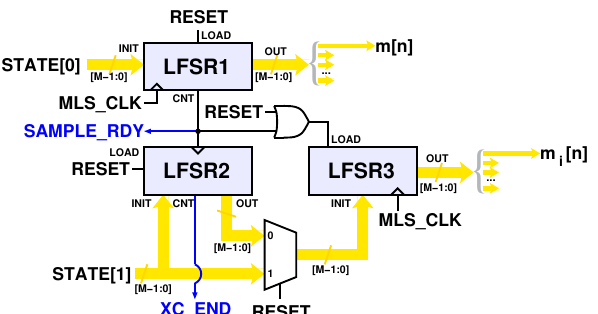
Figure 7. Circuit schematic of the digital control unit (DCU) for the generation of MLS sequences.